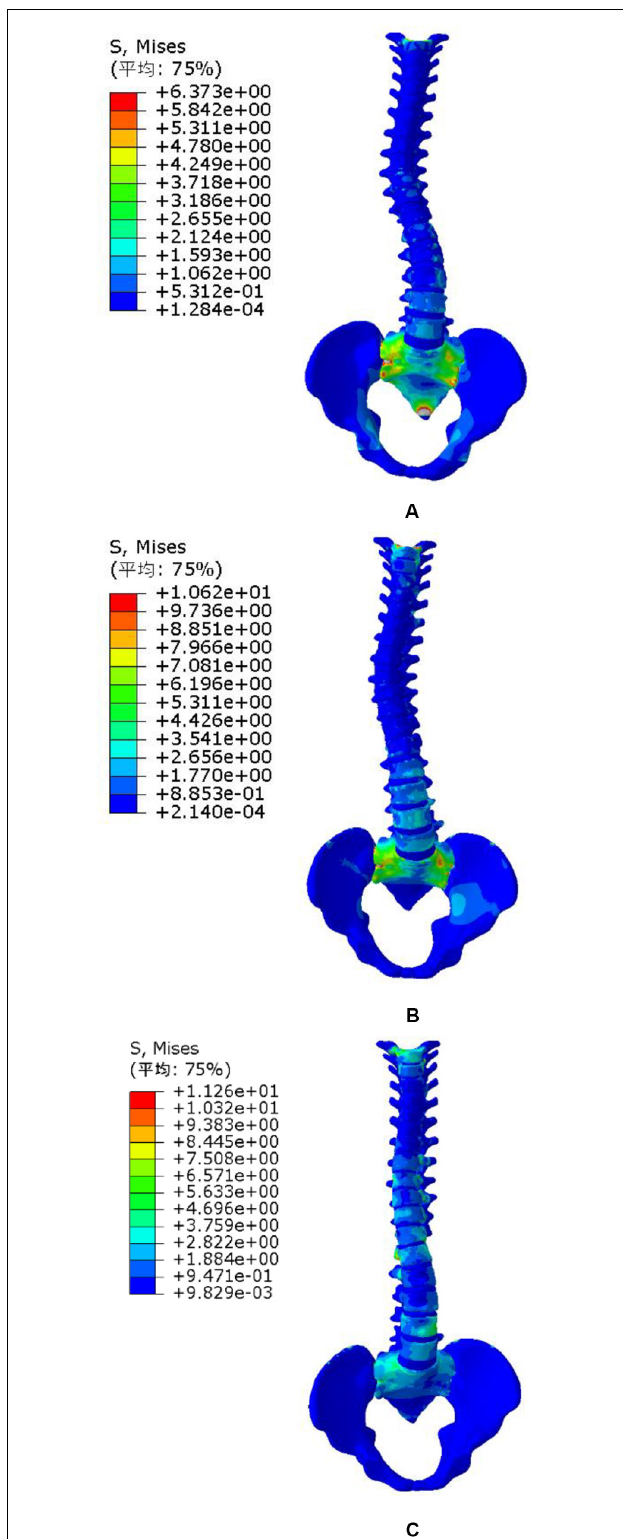
FIGURE 6 | Spine stress under different strap tension. (A) 20N trap tension, (B) 40N trap tension, and (C) 60N trap